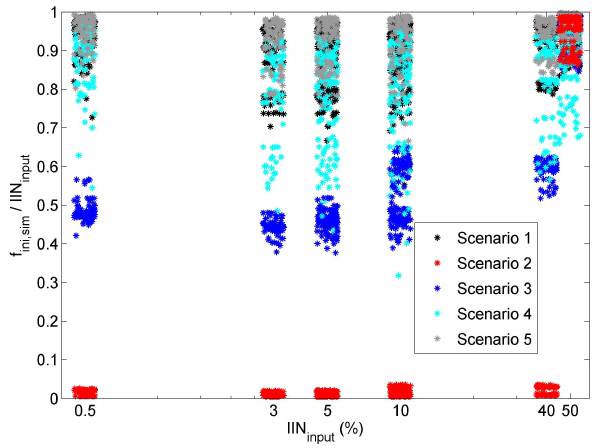
Fig. 2. The ratio of the simulated (negative or positive) charged frac- tion at 1.8nm and the fraction of (negative or positive) ion-induced nucleation used as input in the model as a function of the fraction of (negative or positive) ion-induced nucleation. The colours de- note the growth scenario used in the simulation as indicated in the legend. A random variation of up to 10% is added to the values on the x-axis to make data points more distinguishable. The data points from the simulations with 0% of ion-induced nucleation are excluded from the